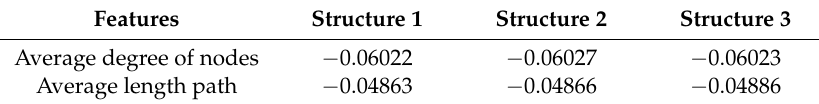
Figure 26. Effect of node removing on values of average length path. Table 6. The average increment/decrement of features.